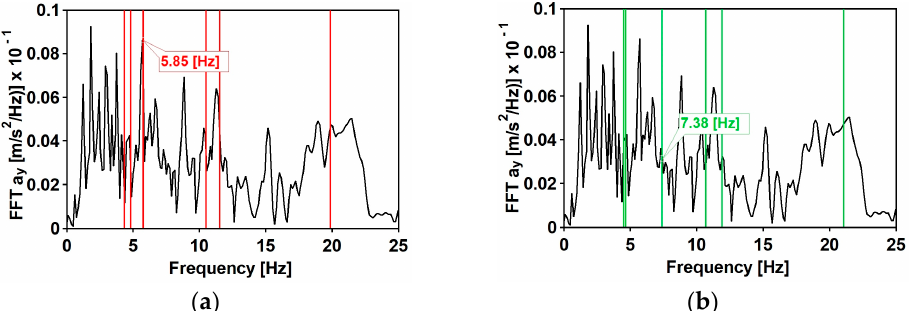
Figure 25. The natural frequencies of the footbridge against the background of the horizontal com- ponent of the wide spectrum shock: ( a ) experimentally obtained natural frequencies of the footbridge; ( b ) the natural frequency obtained from FIX_Ovhg model.